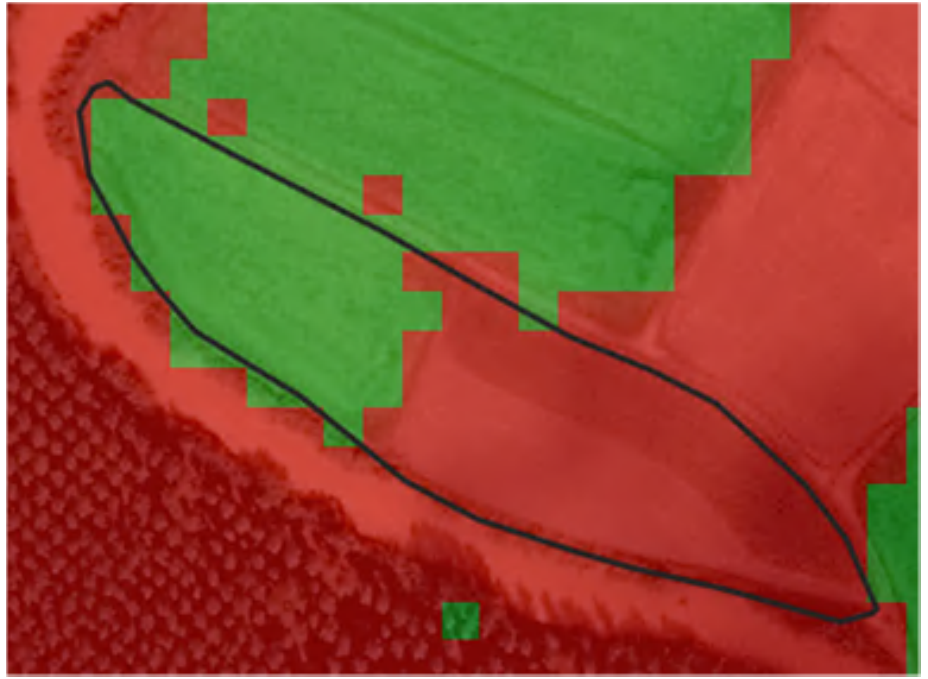
Figure 21. Classification of the plot suspected of not meeting the conditions by ML-based method. Table 12. Pixel distribution of the zonal statistics for suspicious plot.